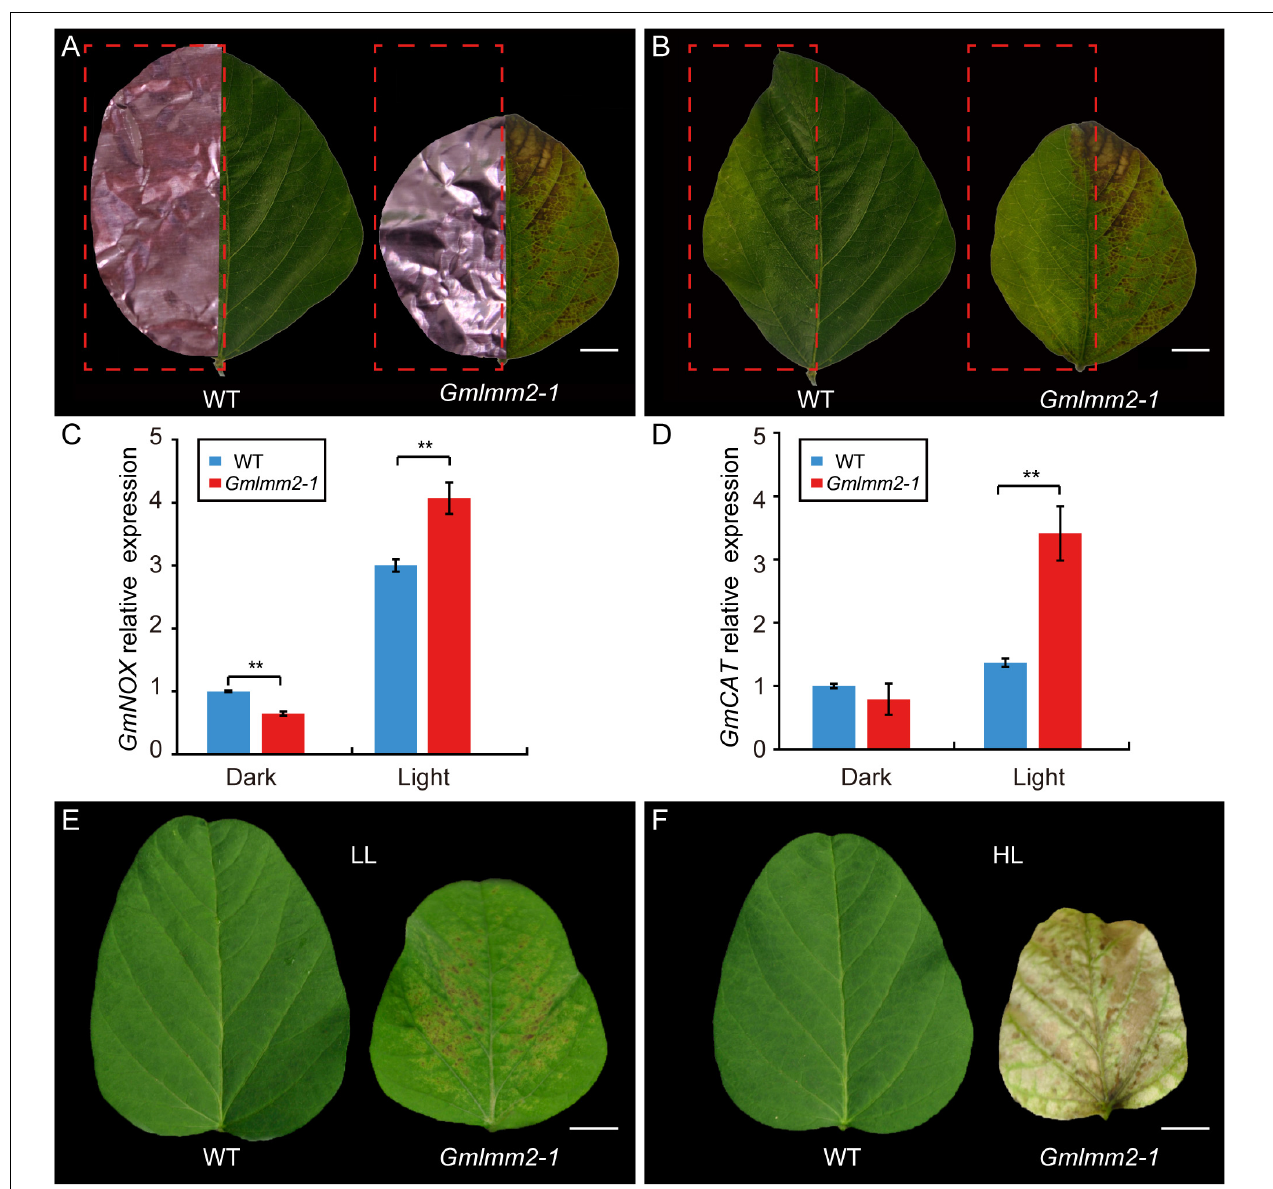
FIGURE 5 | Light avoidance assay in leaves of “Williams 82” and the Gmlmm2-1 mutant before (A) and after (B) removing the shading foils. Scale bars = 0.5 cm. Comparison of expression levels of GmNOX (C) and GmCAT (D) between shaded (Dark) and un-shaded (Light) half leaflet. Phenotype of leaf growing under (E) lower intensity light (LL) and (F) high intensity light (HL). Scale bars = 1 cm. Asterisks’ indications are same as Figure 1